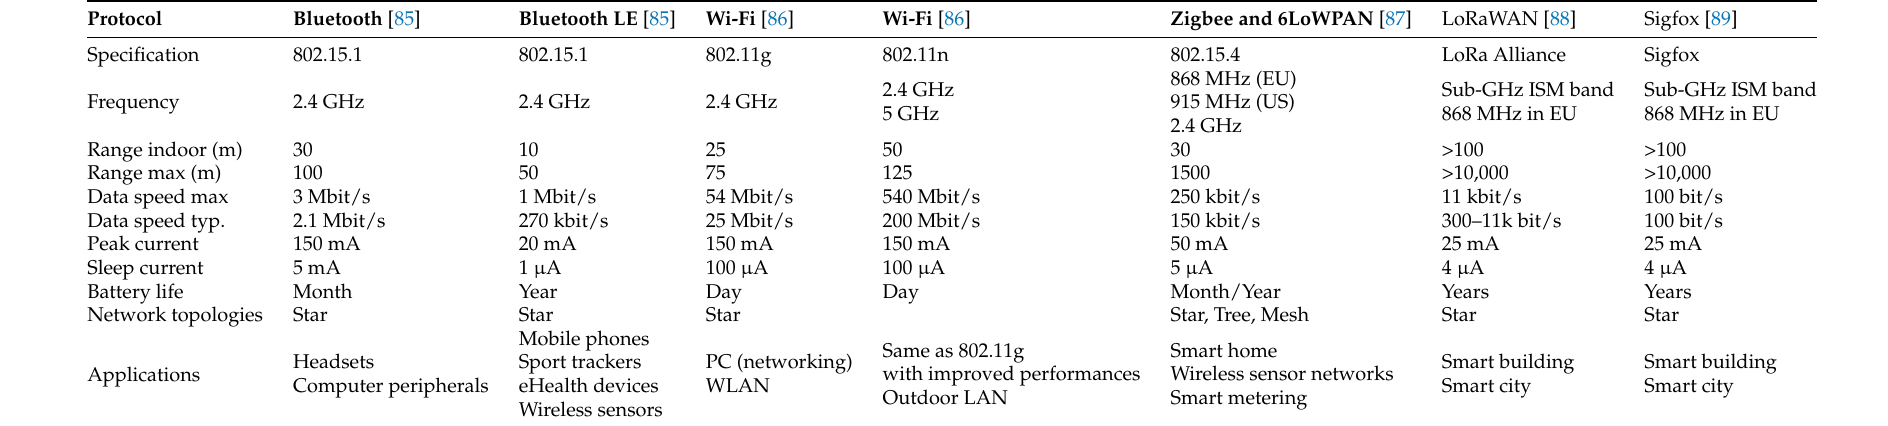
Table 4. Radio transmission protocols